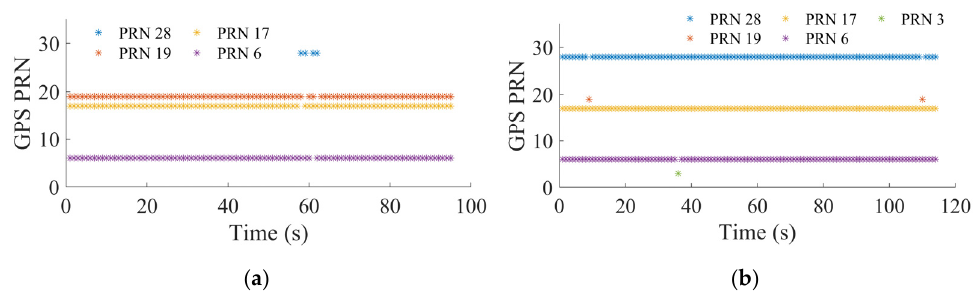
Figure 22. Time series of selected GPS PRN when 3 satellites are visible. ( a ) Clockwise. ( b ) Counter-clockwise.